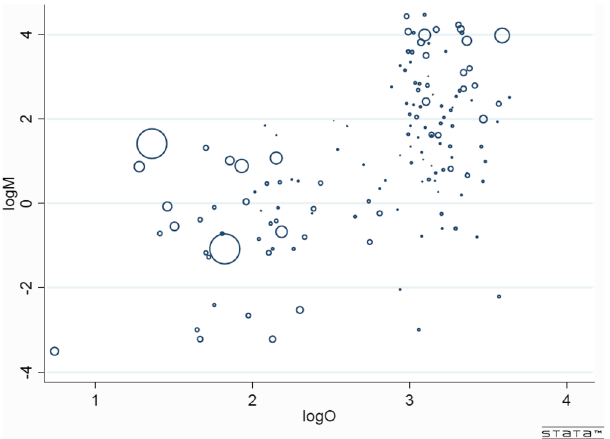
Figure 5. COVID-19 Mortality and Proportion of Obese in Adult Populations (142 countries hosting more than 7.5 billion people). Each circle, with radius proportional to population size, represents a country.